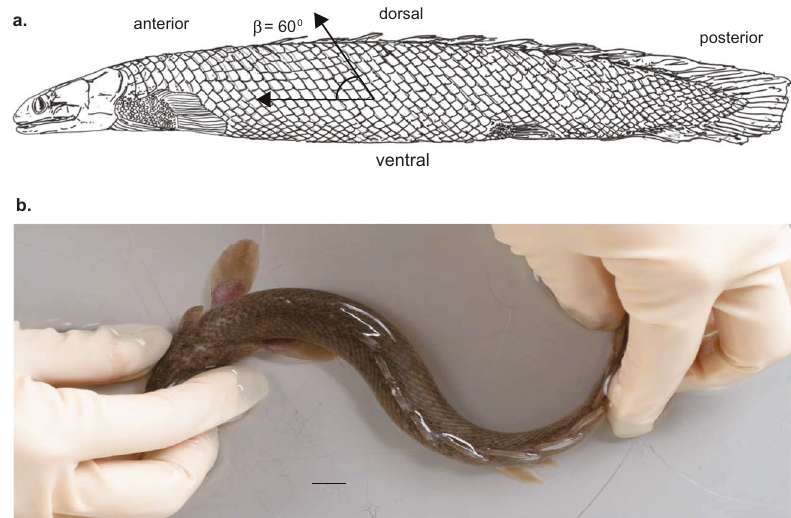
Fig. 1 The P. senegalus exoskeleton. a Schematic of the left side of a fi sh showing the helical arrangement of scales with angle β = 60° between the helical (paraserial) axis and the horizontal plane (sketch by the authors). b Anesthetized P. senegalus specimen (body length = 219 mm) exhibiting bi-directional body curvature in axial bending. Scale bar = 10 mm. Table 1 Displacement range, stiffness (K), and interscale mobility mechanisms for each loading phase of each prototype orientation ( φ